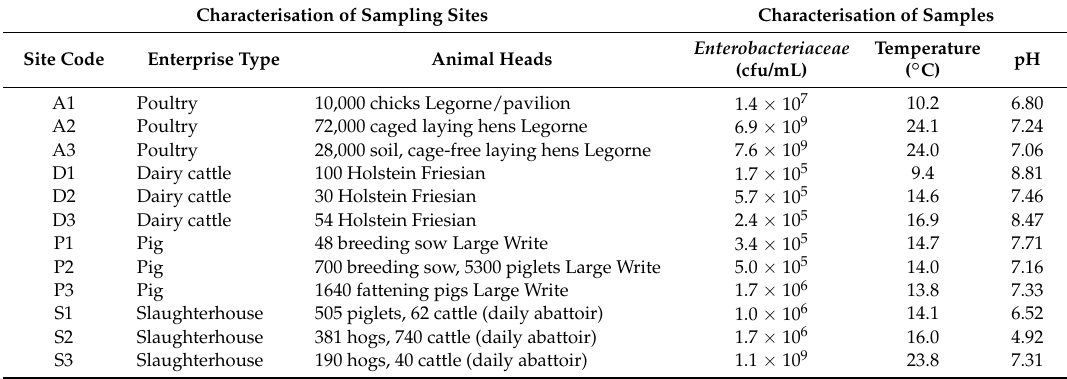
Table 1. Animal heads per sampling site, average microbiological and physical-chemical parameters of